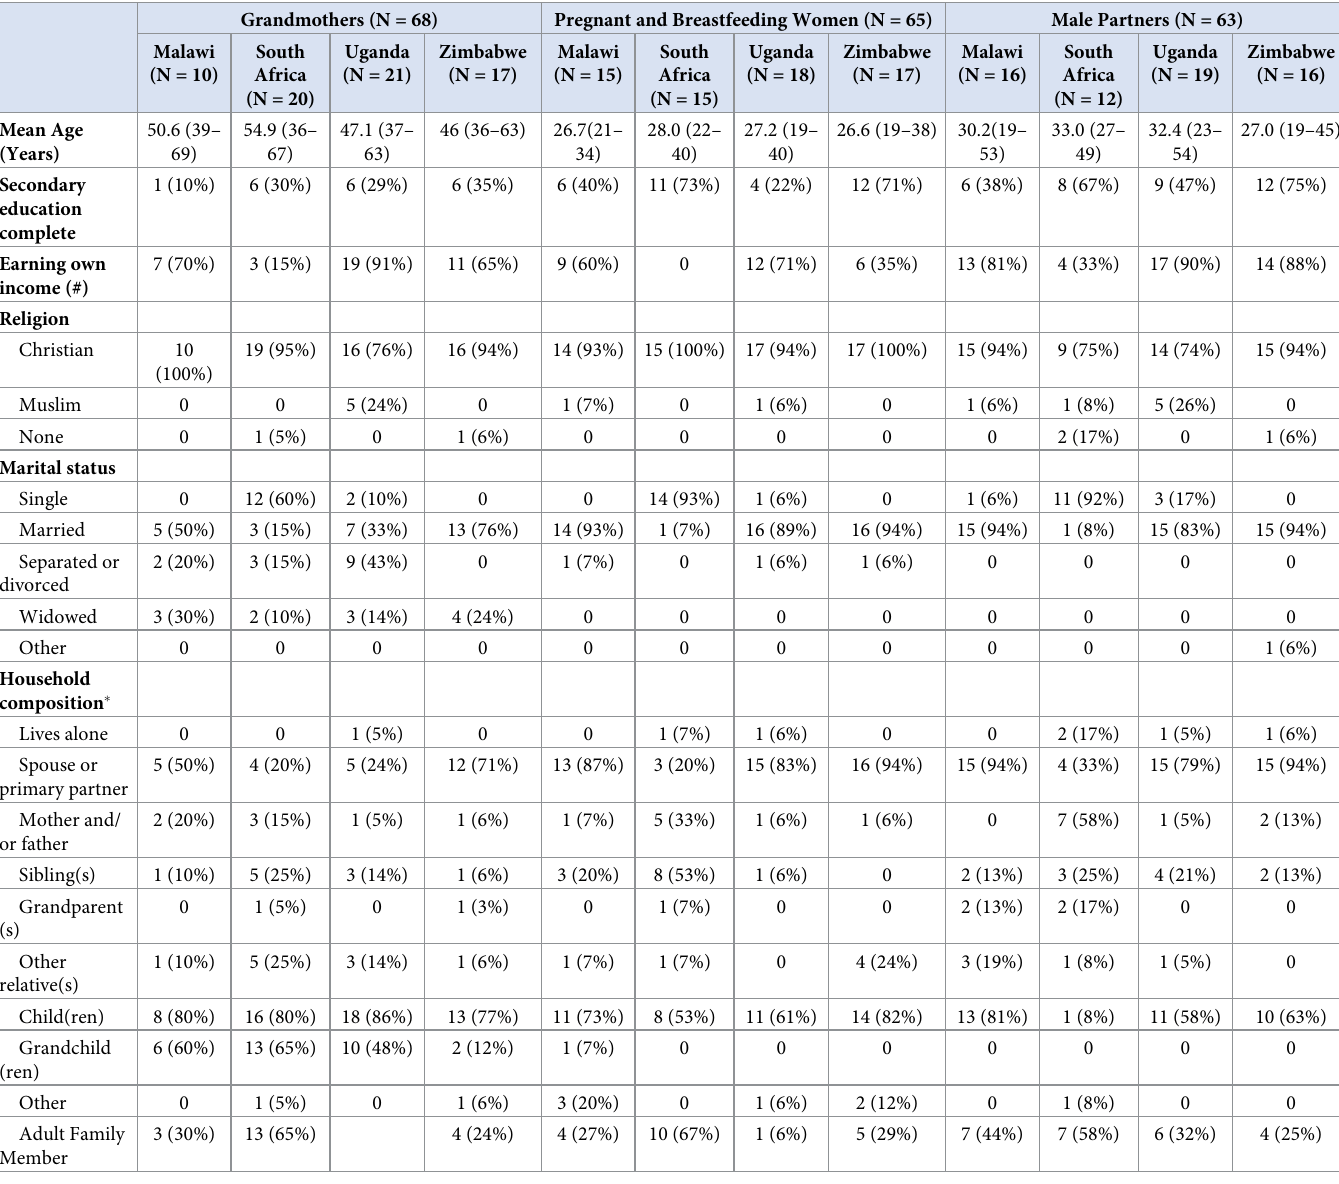
Table 1. Demographic information across the four participating study